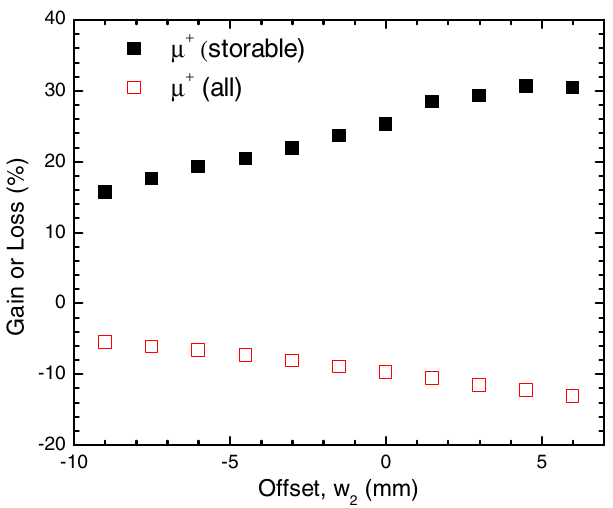
FIG. 10. Gain or losses of muons at the end of M5 compared to the case without a wedge as a function of the distance between the apex of W 2 and the beam line center. The red squares show the total intensity while the black squares show the storable muons only. As storable muons, we define muons that are contained within 0.15% of the central momentum. The simulation assumes two ð C 2 H 4 Þ n absorbers with a thickness of 125 mm and a 162º angle. The apex of W 1 is fixed at the beam line center.